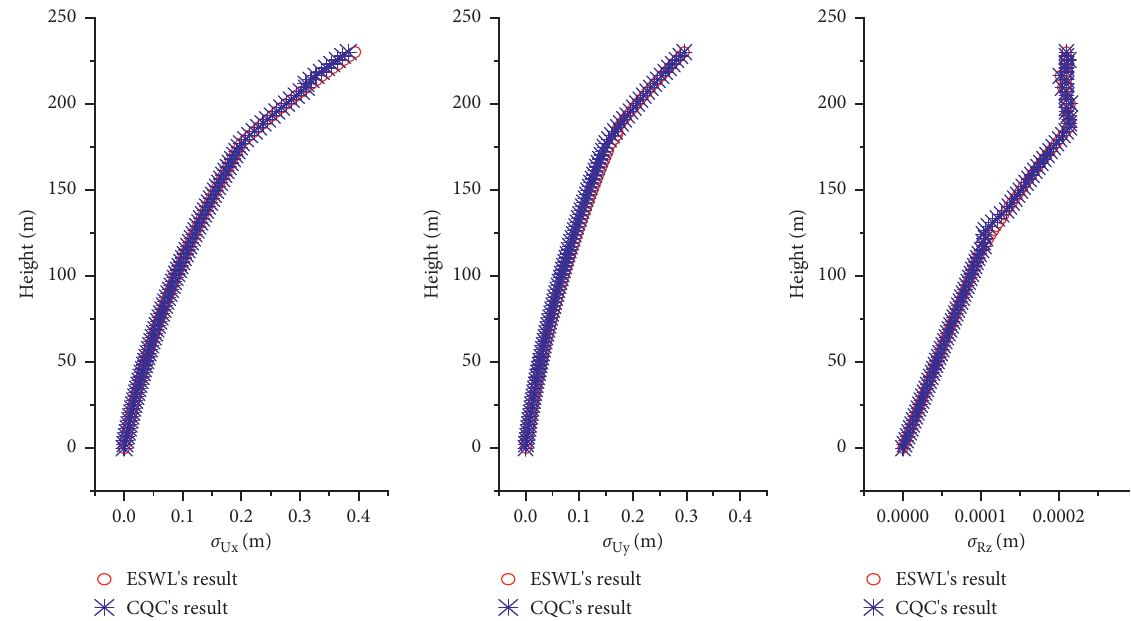
Figure 11: RMS displacement of structure (90 ° wind direction, 100 years return